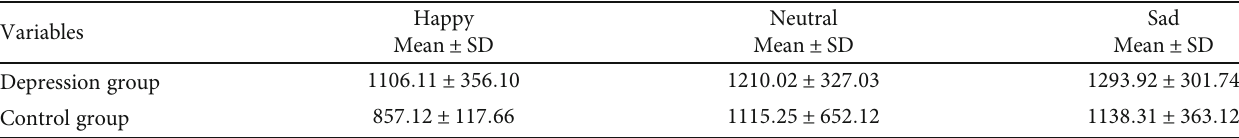
Table 3: Response time of facial expression category between depression and control groups ( n = 30